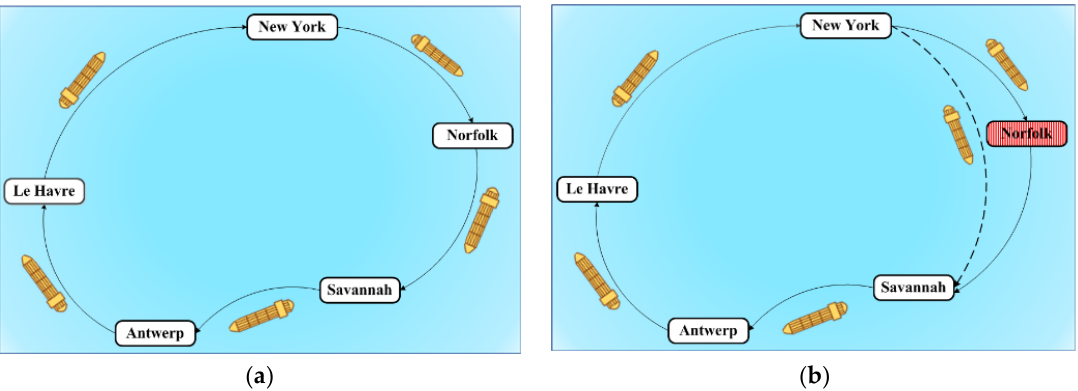
Figure 4. An example of port skipping: ( a ) port rotation before schedule recovery; ( b ) port rotation after schedule recovery.